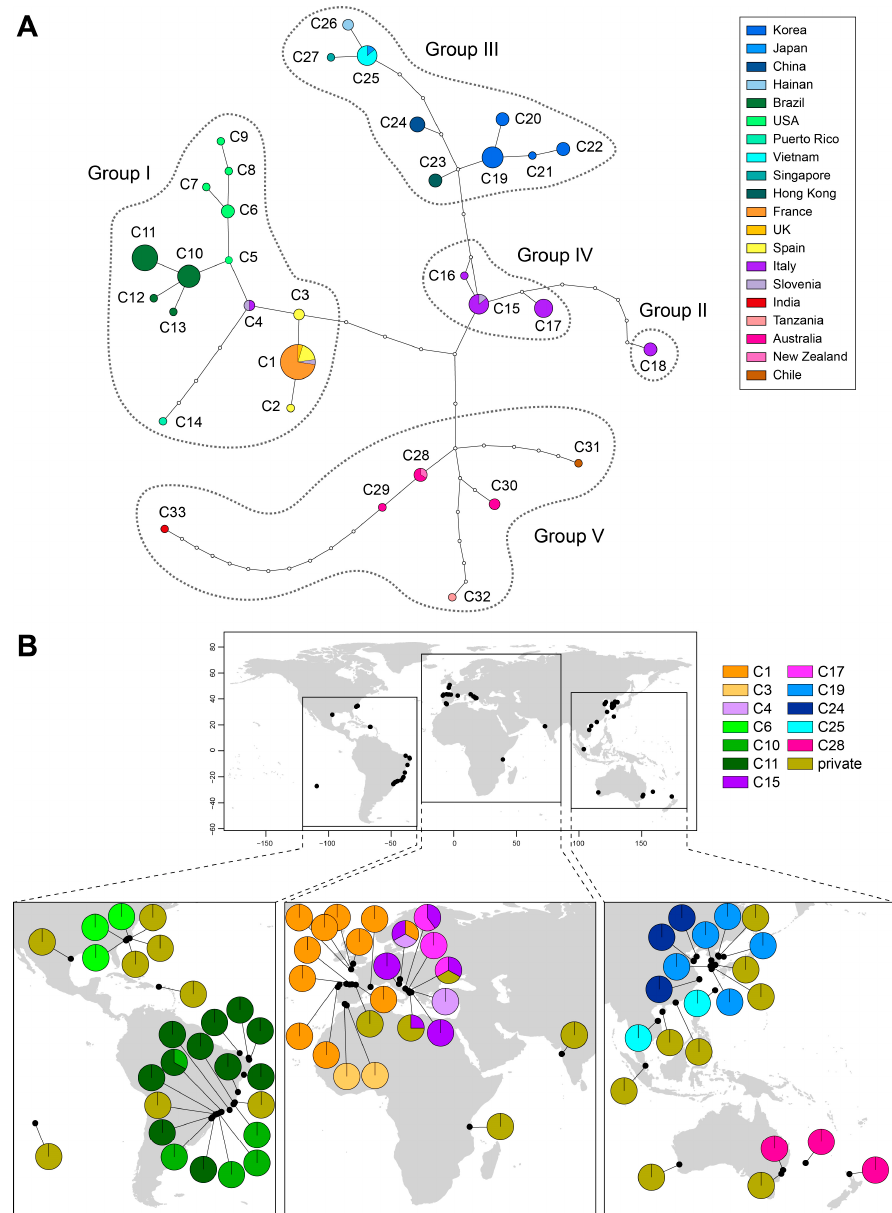
Figure 2. TCS-derived network and geographic distribution of 33 haplotypes of G. crinale based on mitochondrial COI-5P. ( A ) Haplotype network. Each circle denotes a single haplotype with size proportional to frequency. Small open circles represent missing haplotypes. Haplotypes are colored according to the country as shown in the key. Haplogroup follows phylogroups in Figures 1 and S1. ( B ) Distribution map of haplotypes. Pie charts denote the proportion of haplotypes present in each location. Private and shared haplotypes are colored as shown in the